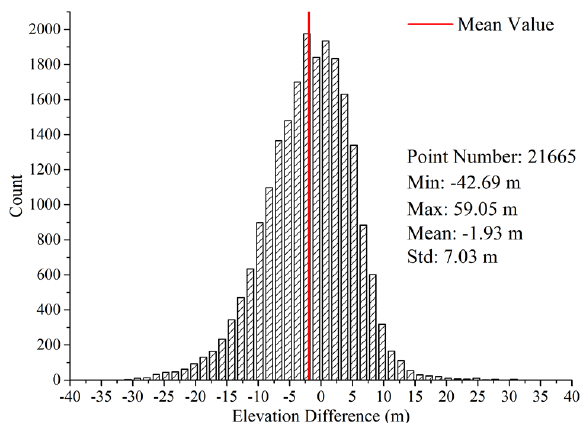
Figure 6. Histogram of the elevation differences between points from the ASTER DEM and ICESat